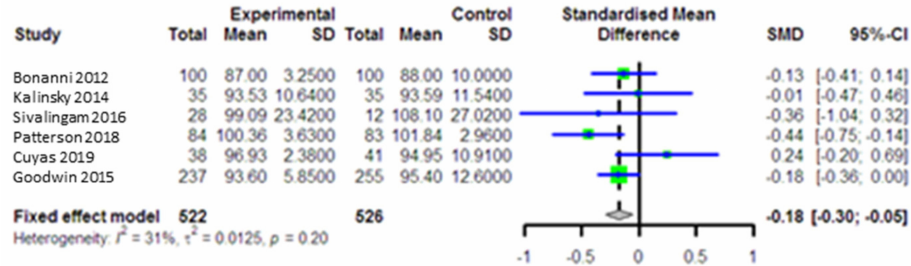
Figure 3. Forest plot of the meta-analysis to compare plasma fasting blood sugar (FBS) levels between intervention and control groups.